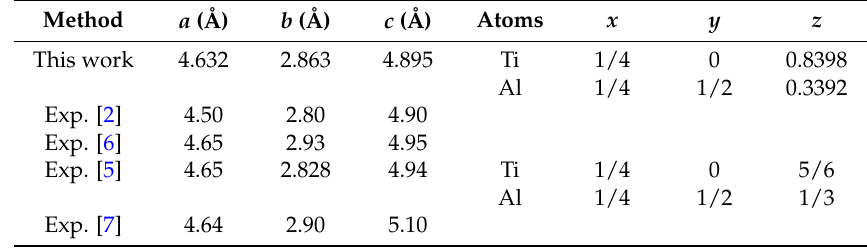
Table 2. The equilibrium lattice constants ( a , b , c ) and atomic Wyckoff positions ( x , y , z ) of B19 TiAl.